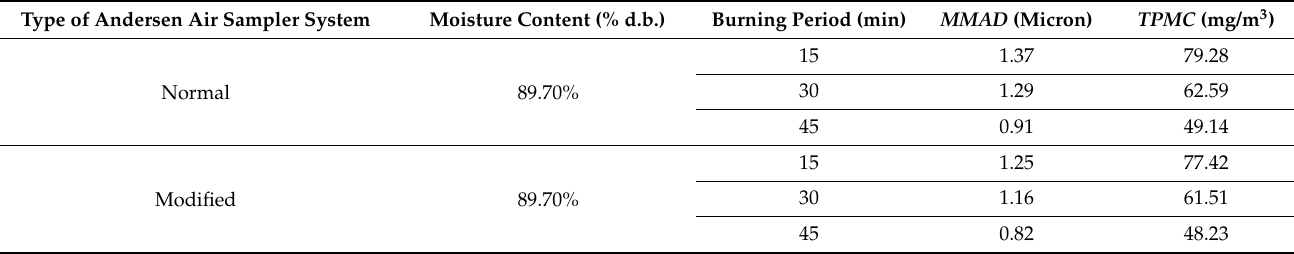
Table 1. The comparison of MMAD and TPMC value results measured from a normal and modified 8-stage Andersen air sampler